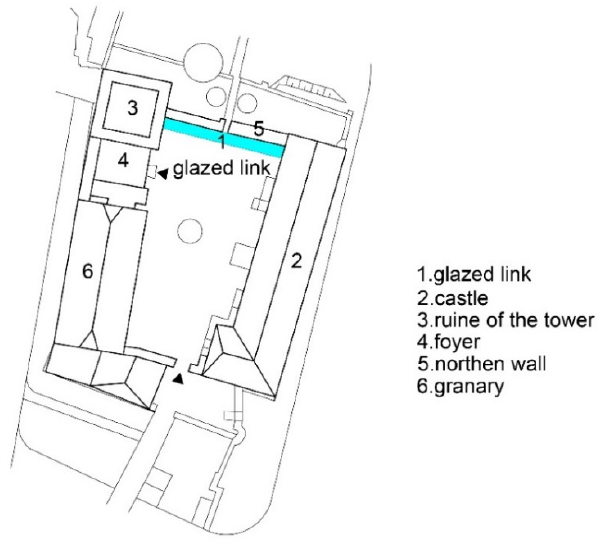
Figure 8. Glass link in the Grimma Castle plan (figure by the author).